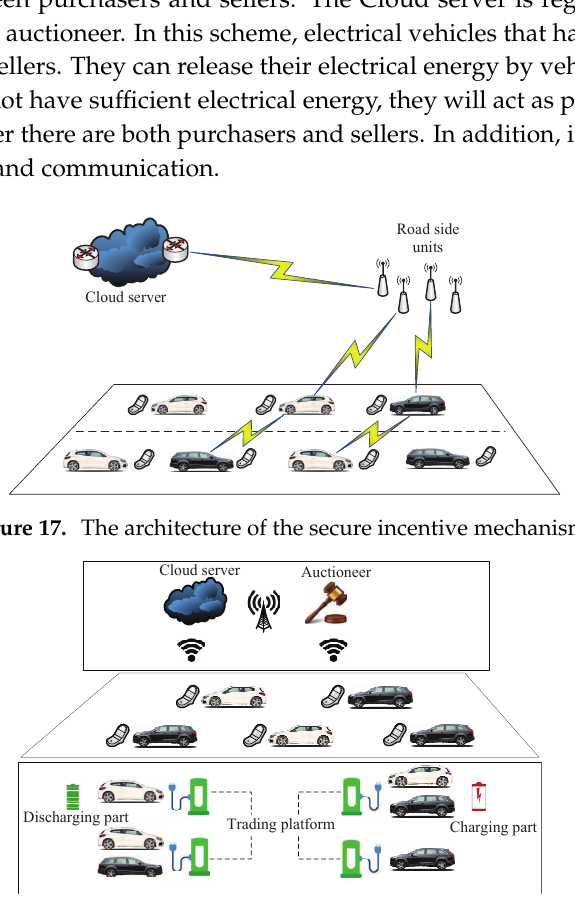
Figure 18. The architecture of the secure double auction scheme.